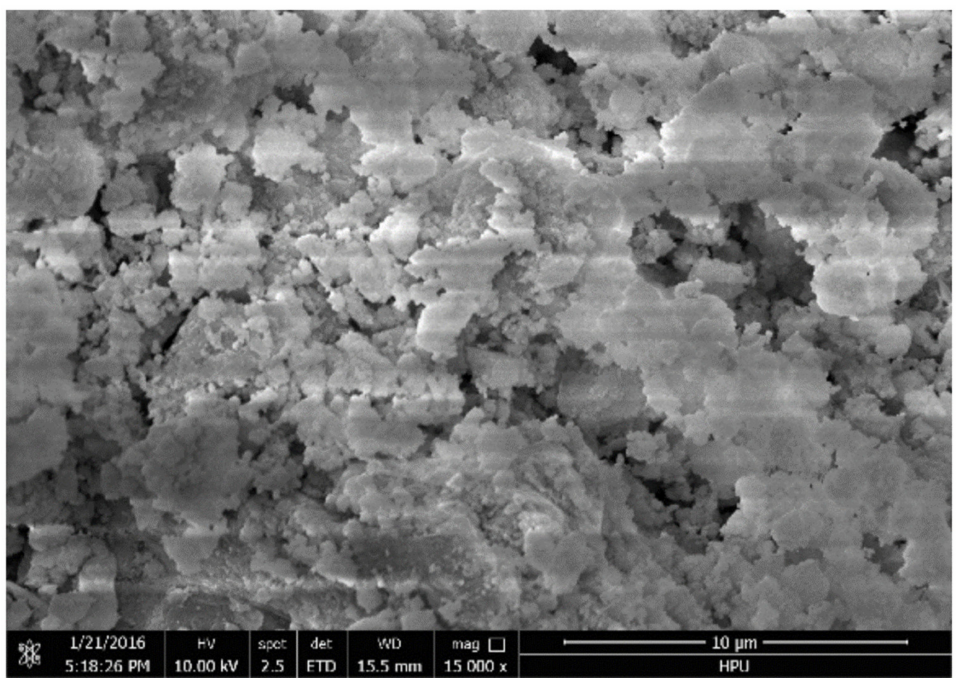
Figure 4. SEM micrograph of red mud, adopted from Zhang et al., open access journal Applied Sciences, 2018